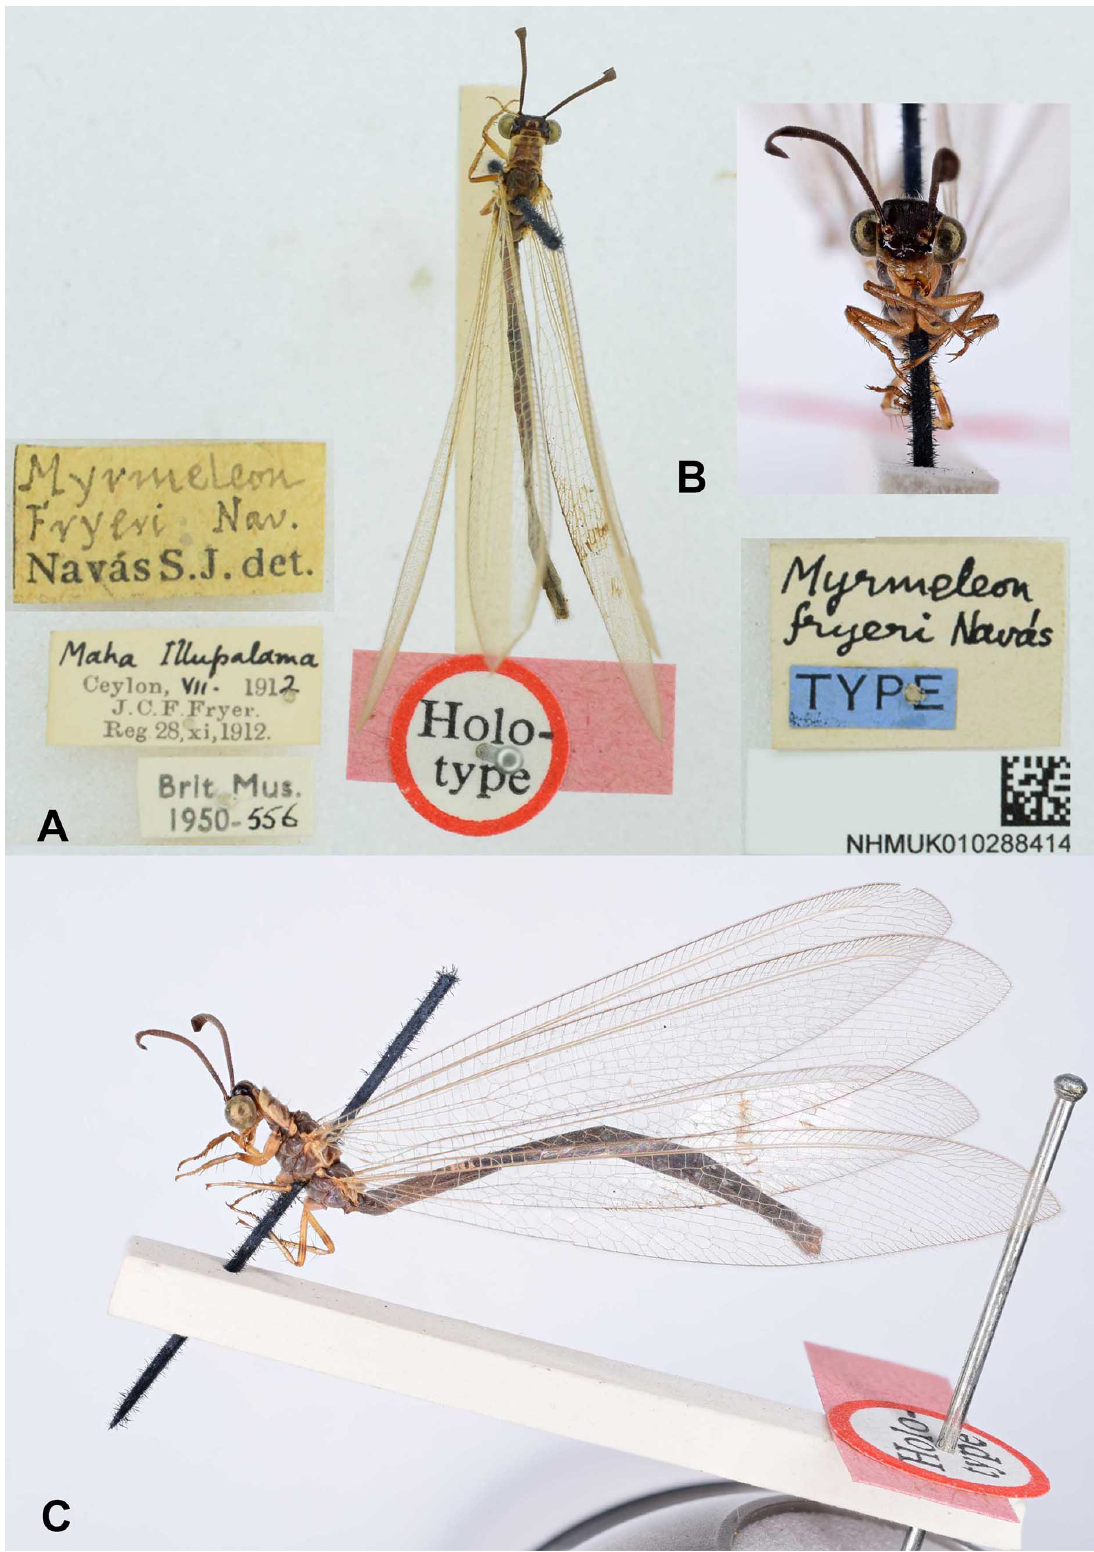
Fig. 10. Holotype of Myrmeleon fryeri Navás, 1914 (NHMUK). A . Male, dorsal habitus. B . Head, frontal view. C . Lateral